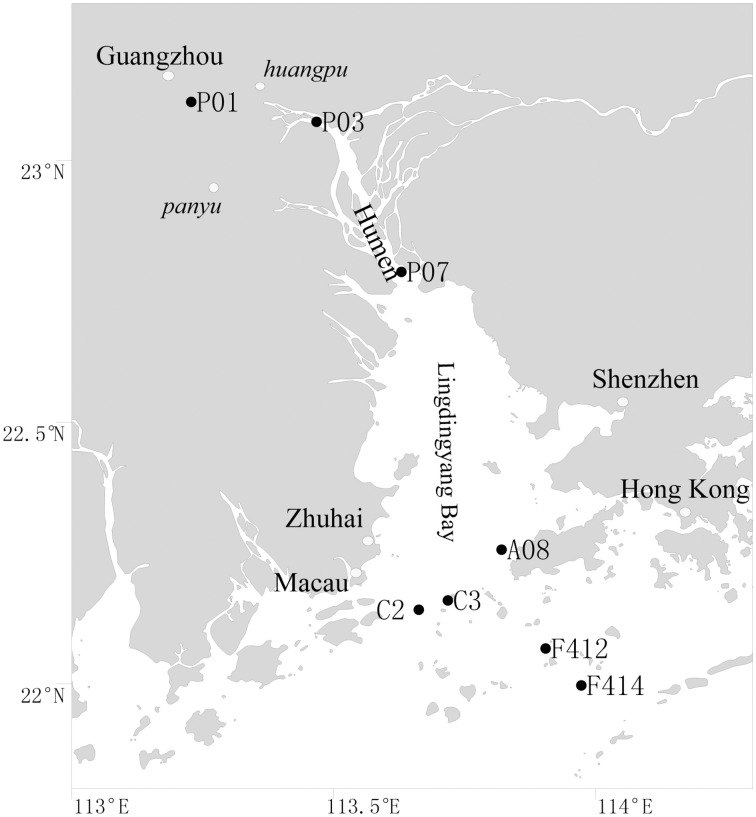
Location of sampling sites in the Pearl Estuary.